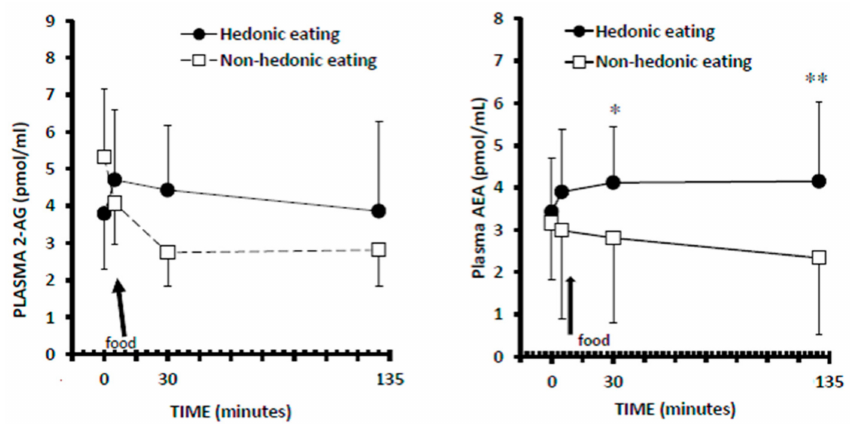
Figure 2. Plasma levels of 2-arachidonoyl glycerol (2-AG) and arachidonoylethanolamide (anandamide, AEA) in hedonic and non-hedonic eating in obese patients with binge-eating disorder. Data are expressed as mean ± SD. The arrows indicate when participants started to eat the test meal. * p < 0.05, ** p < 0.01 as compared to non-hedonic eating (post-hoc Tukey’s